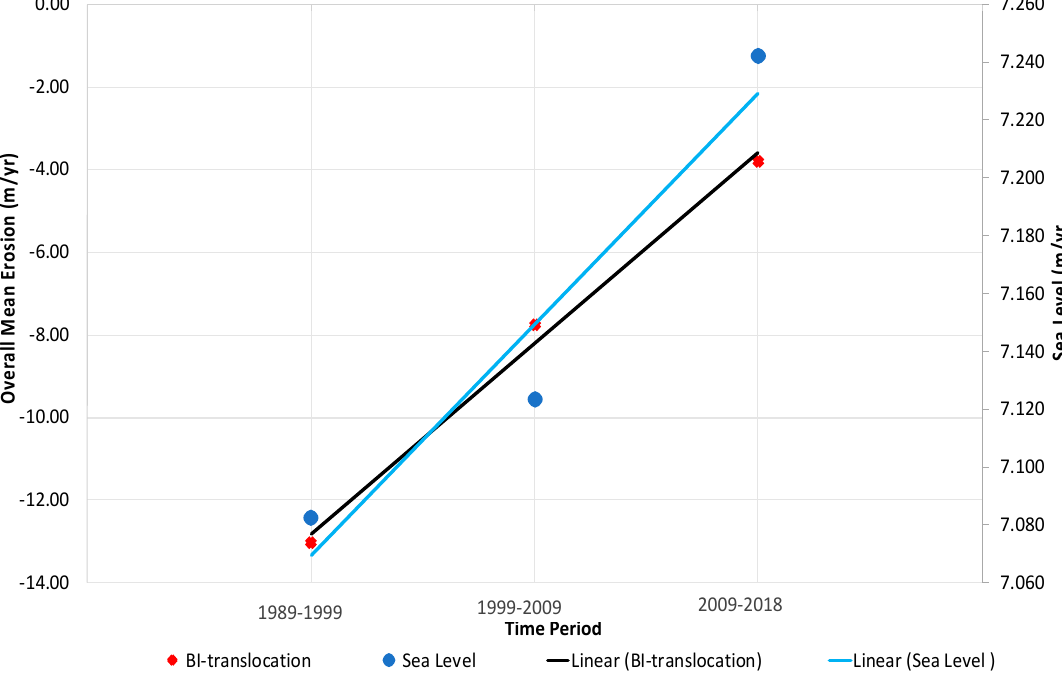
Figure 9. Graphical representation of the mean sea level estimates derived from PSMSL data for Karachi Station during the period 1989–2015 with a linear trend (blue color) vs. overall trend of mean erosion of the barrier islands (black color).